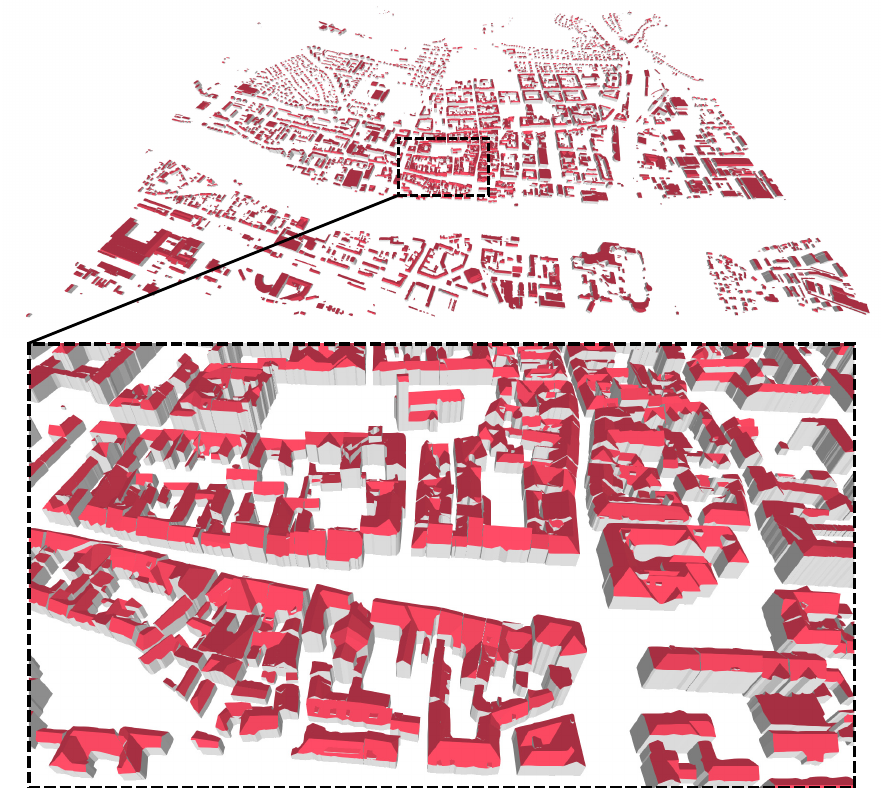
Figure 7. Reconstructed city model for the height jumps and segmented planar faces from Figure 6c and 6d,